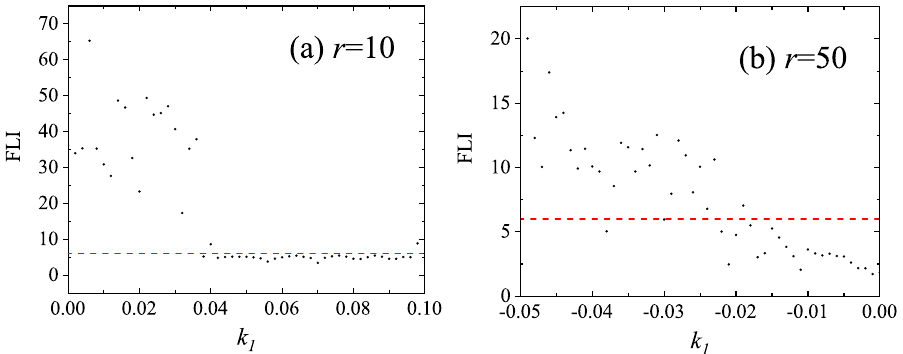
Figure 10. Same as Figure 8, but k 0 in Figure 8 is replaced with k 1 . ( a ): k 0 = 5 × 10 − 4 and the initial radius is r = 10; chaos is ruled out as k 1 > 0.042. ( b ): k 0 = 10 − 4 and the initial radius is r = 50; chaos is enhanced as k 1 < − 0.018.